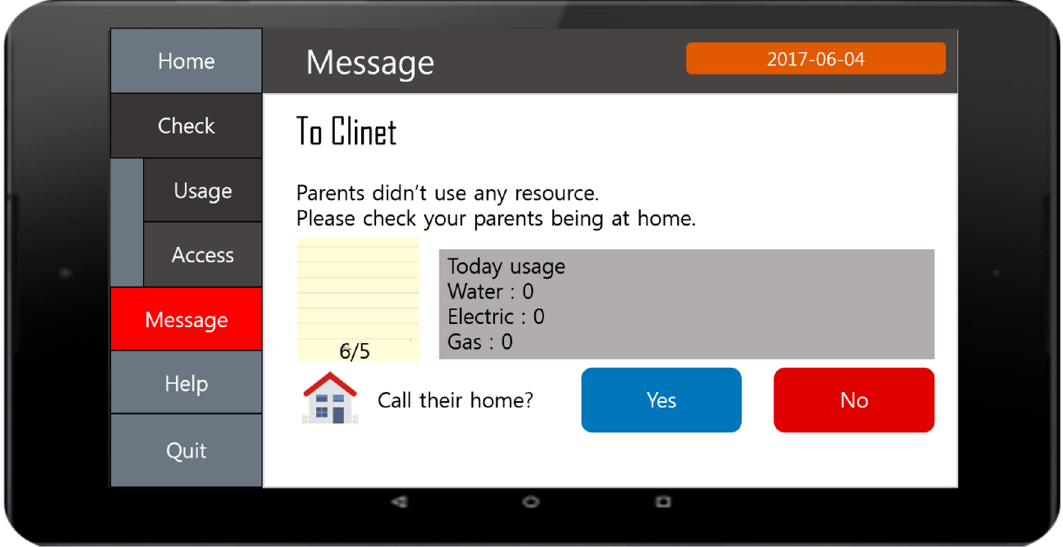
Figure 17. The User Interface for Reporting the Current Situation and Advising a Phone Call.